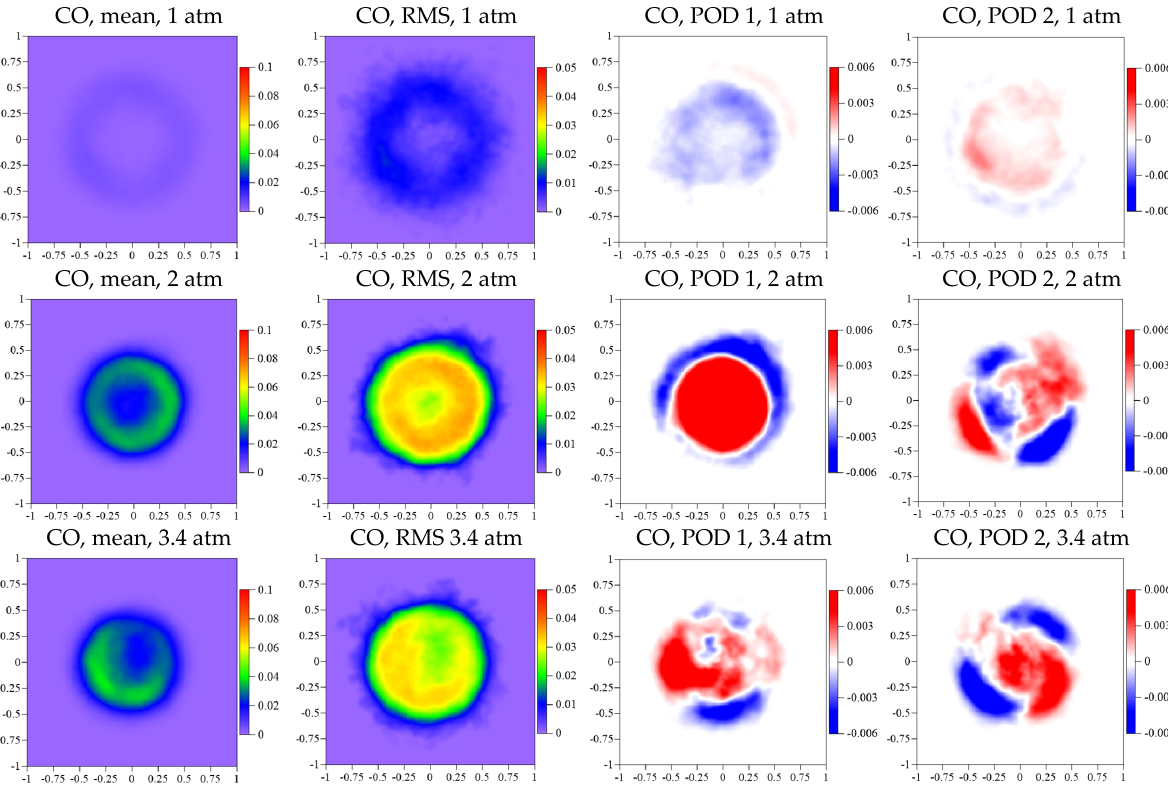
Figure 19. Mean and variation in the CO concentration field and the first and second POD modes.